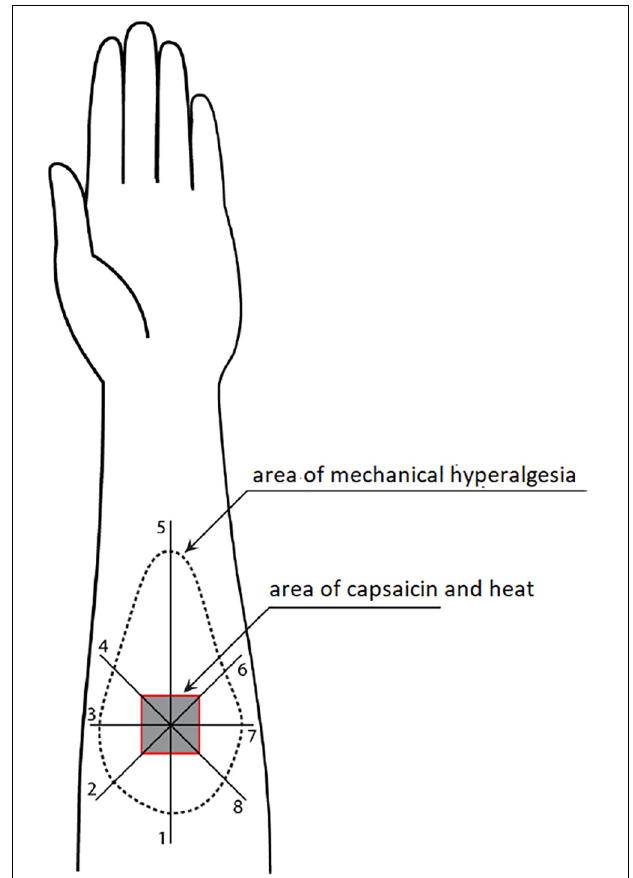
FIGURE 1 | Illustration of measurement for the area of mechanical